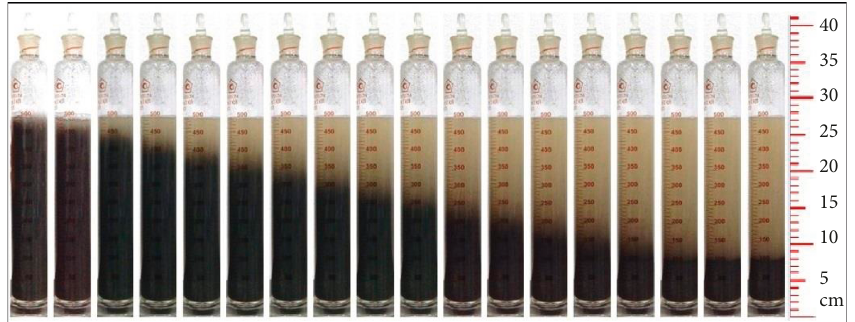
Figure 3: Schematic of tailing settling experiment.